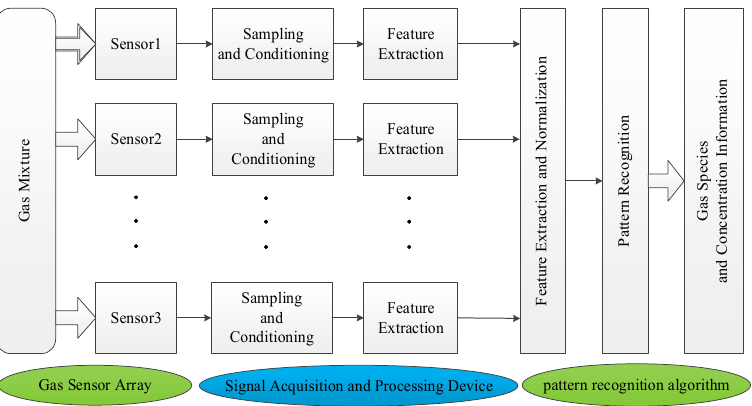
Figure 1. Block diagram of a machine olfactory system.